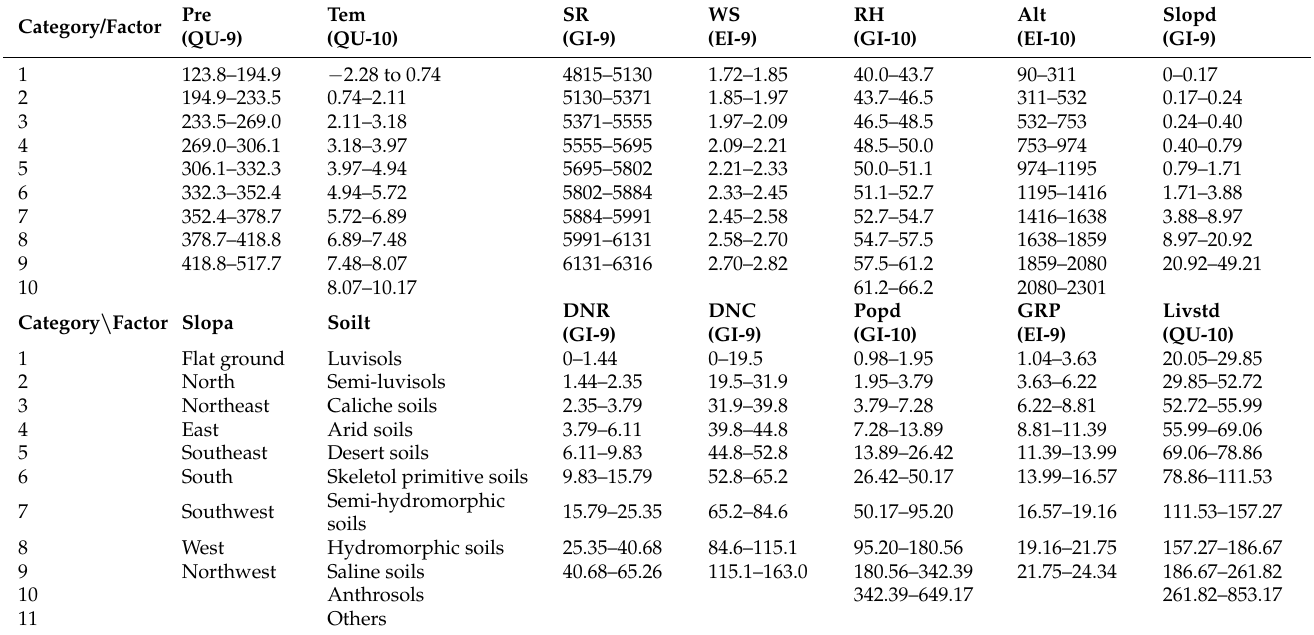
Table 2. The classification of potential driving factors. The units of Pre, Tem, SR, WS, RH, Alt, Slopd, DNR, DNC, Popd, GRP, and Livstd are mm, ◦ C, MJ · m − 2 , m · s − 1 , %, m, ◦ , km, km, person · km − 2 , 10,000 yuan person − 1 , and sheep · km − 2 , respectively. In the parentheses of the table header, QU, EI, and GI correspond to three discretization methods of the quantile, equal interval, and geometrical interval, respectively, and the numbers represent the number of